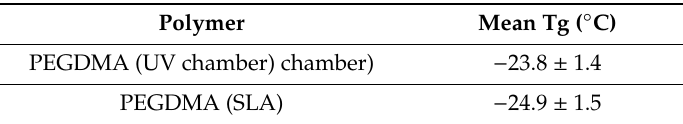
Table 1. Thermal properties of PEGDMA hydrogels prepared via UV chamber and SLA polymerisation determined by